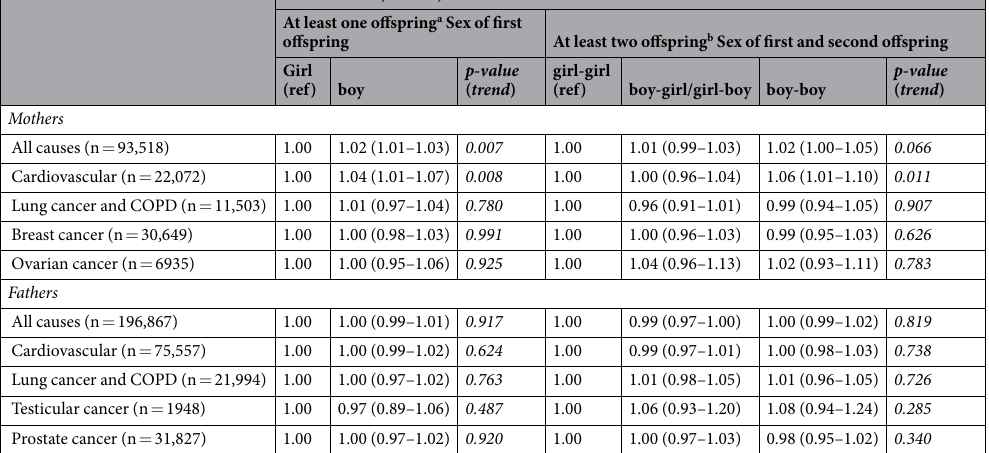
Table 2. Age adjusted hazard ratio of cause specific mortality from the Cause of Death Registry (all cause, circulatory and lung cancer) and incident cancer from the Norwegian Cancer Registry (breast cancer and ovarian cancer) if the first and second offspring sex was boy among fathers and mothers born 1925–54 with follow up of from age 50. a n = 661,013 for women and n = 691,124 for men. Adjusted for year of birth, education and parity. b n = 562,677 for women and n = 584,515 for men. Adjusted for year of birth, education and parity.